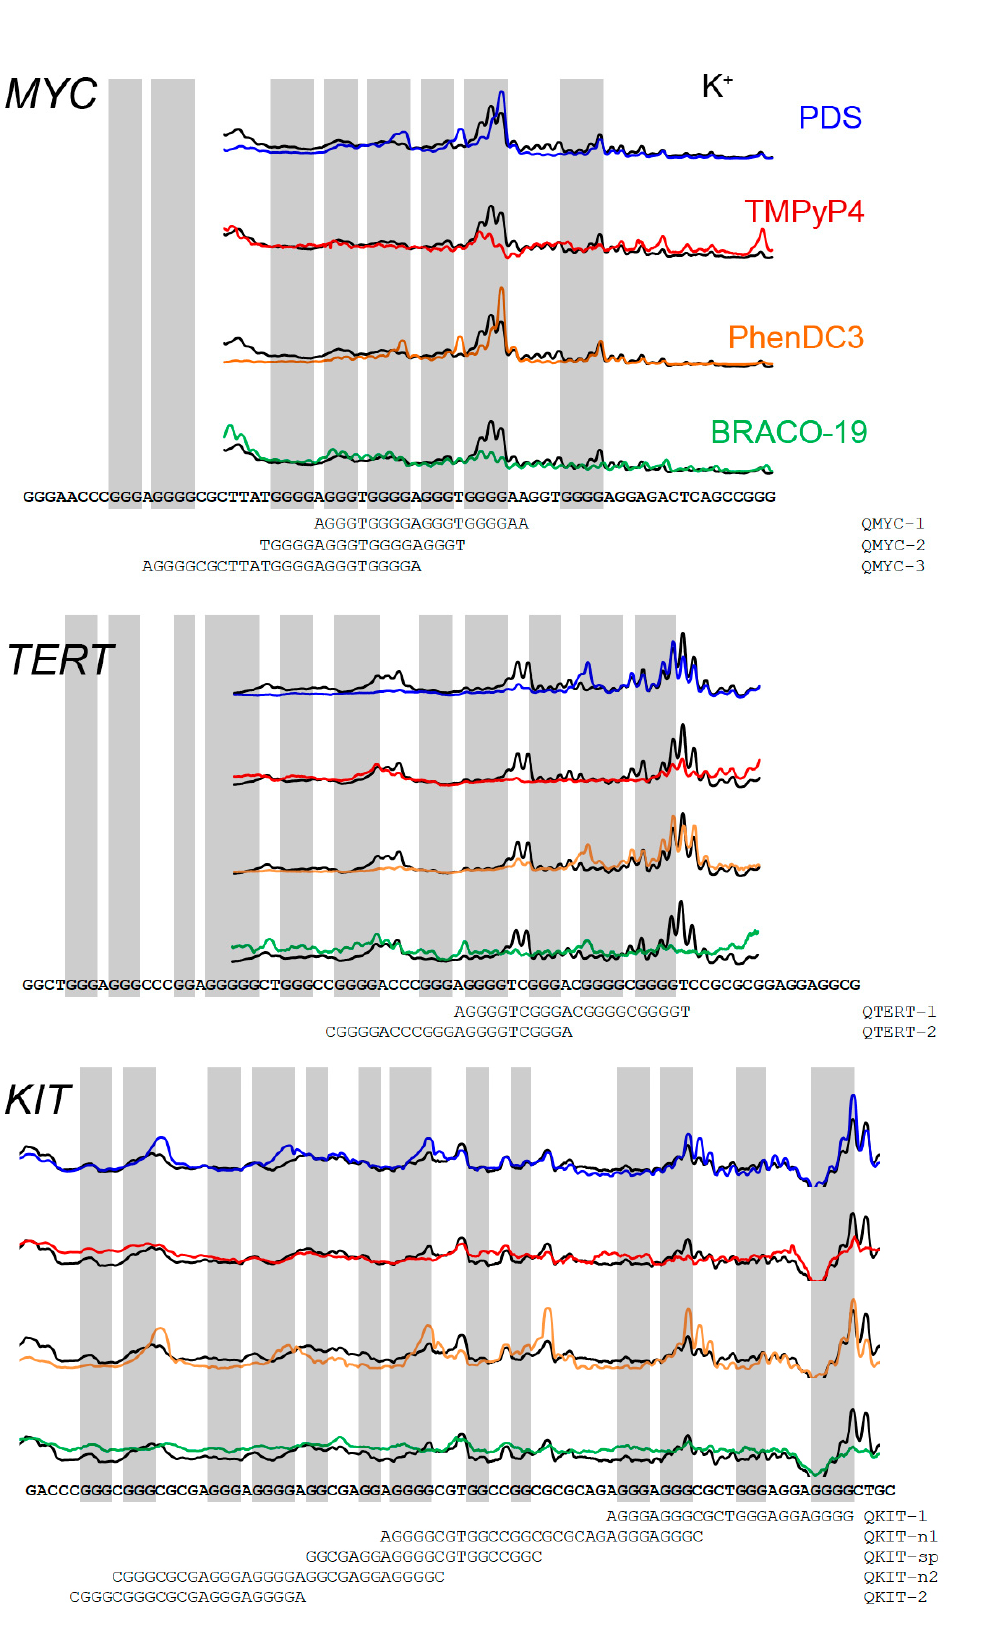
Figure 3. Densitometric profiles of primer extension lanes in the presence of G4-stabilizer in Taq-polymerase elongation reaction. Black—10 mM KCl, blue—0.5 µM PDS, red 1 µM—TMPyP4, orange—0.1 µM PhenDC3, green 5 µM BRACO-19. Oligonucleotides for FRET melting assay are shown under the promoter sequences.